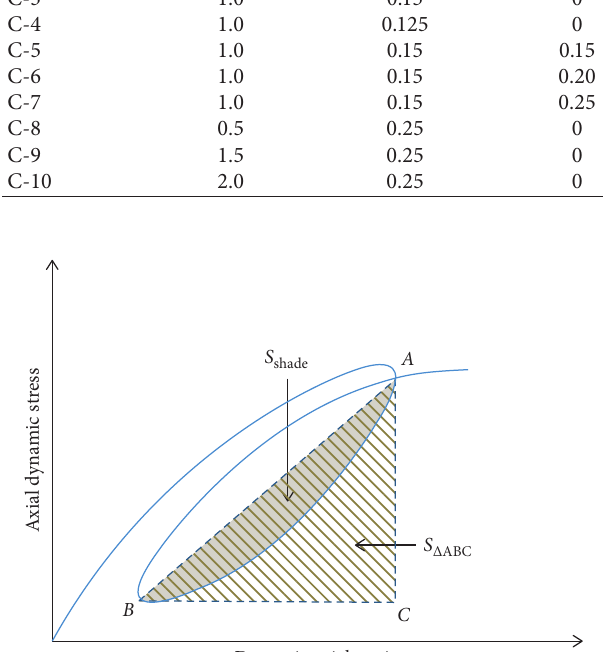
Figure 2: Determination of dynamic